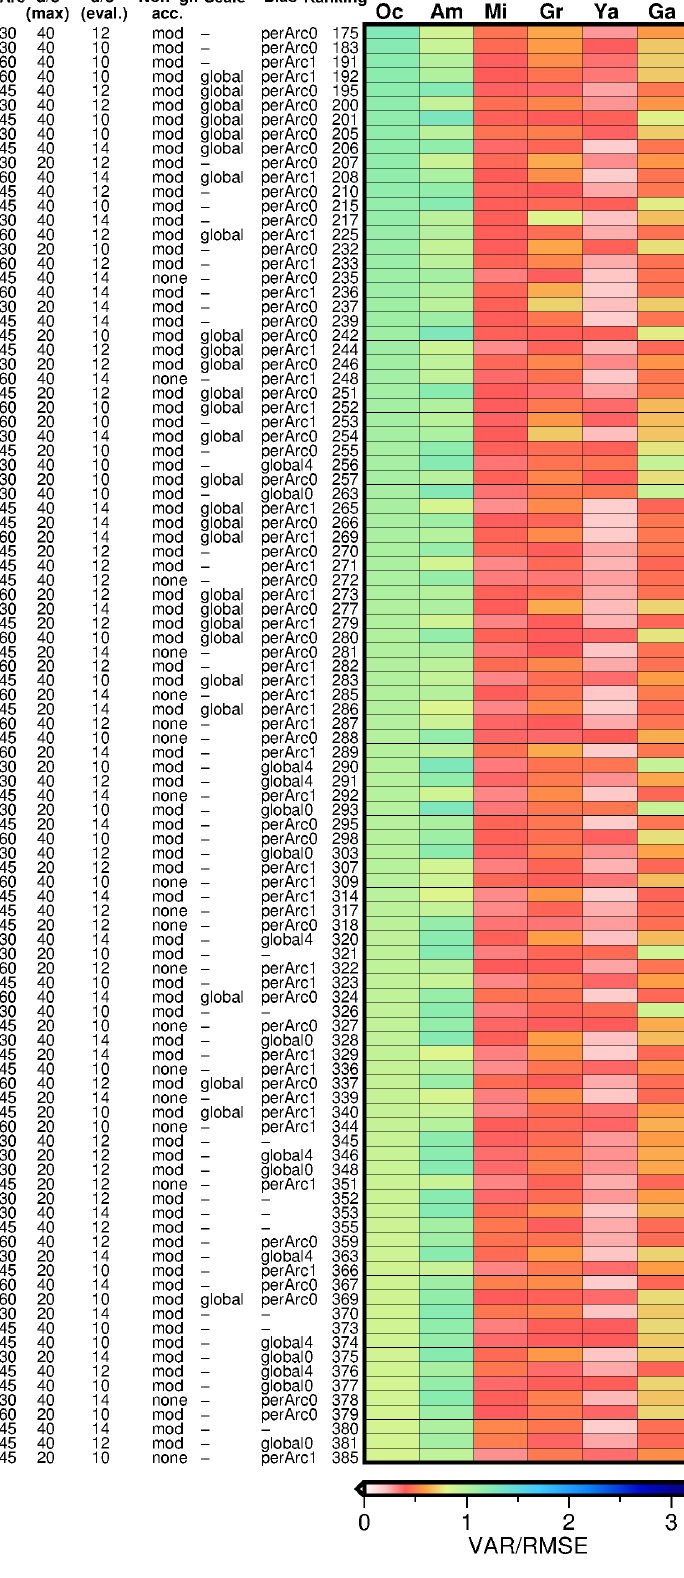
Figure 11. Evaluation of methods (monthly